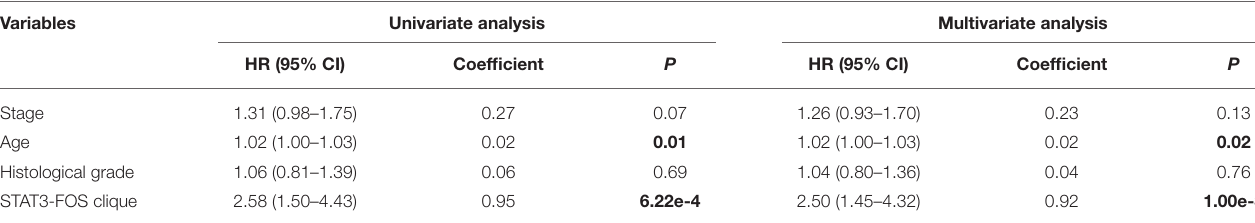
The bold values are representing significant factors (P-values <